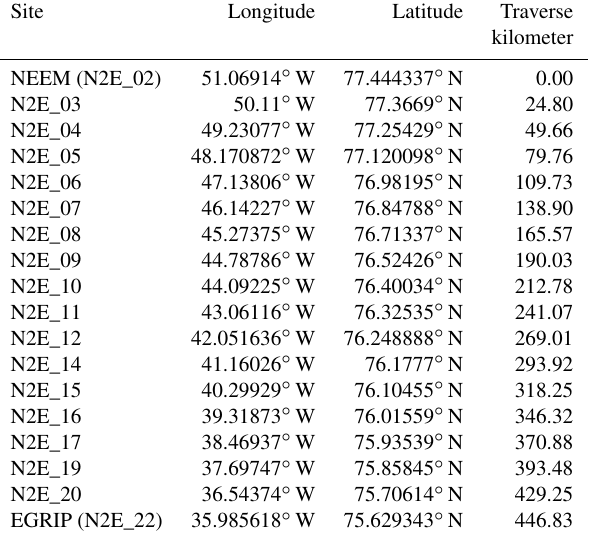
Table 1. Measurement sites along the traverse, see also Fig. 1. The missing liner numbers (e.g., N2E_01) result from multiple samples being taken at some locations. Nonetheless, only one profile per location was used for this study.